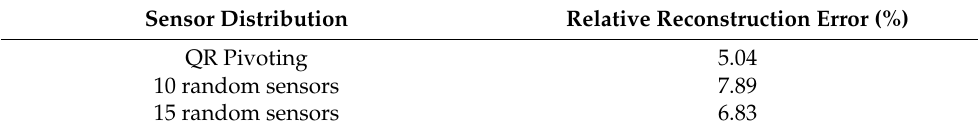
Table 8. Relative reconstruction errors (%) for three sensor distributions.